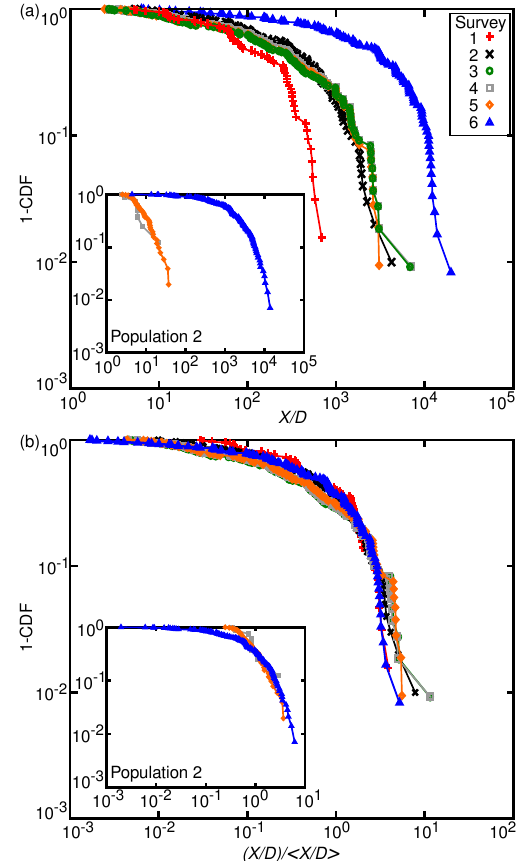
Figure 8. (a) Cumulative dimensionless displacement for each tracer survey for the first population of tracers. Survey number is denoted in the legend. (a) Inset: cumulative dimensionless displace- ment for the second population of tracer particles, installed imme- diately prior to survey 4. (b) Cumulative dimensionless displace- ment data normalized by the mean displacement for each survey for tracer population 1. (b) Inset: cumulative dimensionless displace- ment data normalized by the mean displacement for each survey for tracer population 2.